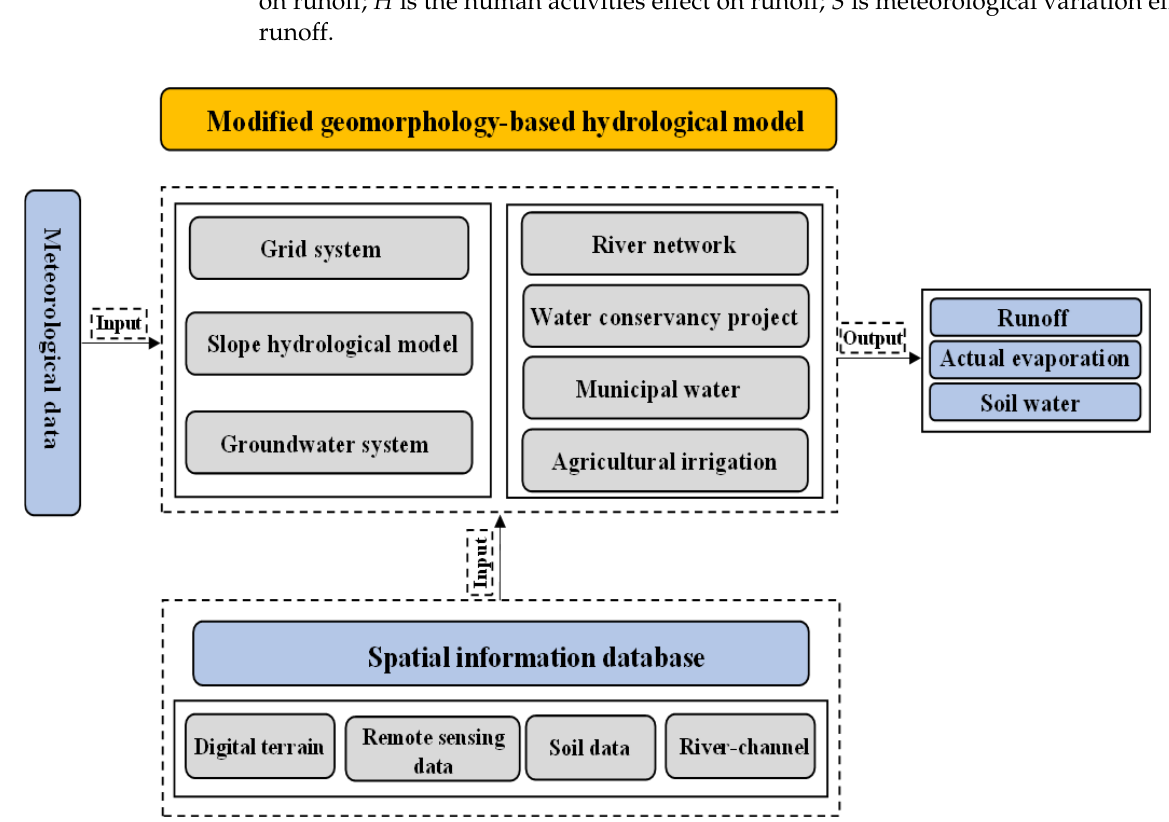
Figure 3. Structural summary of the GBHM used in this analysis.